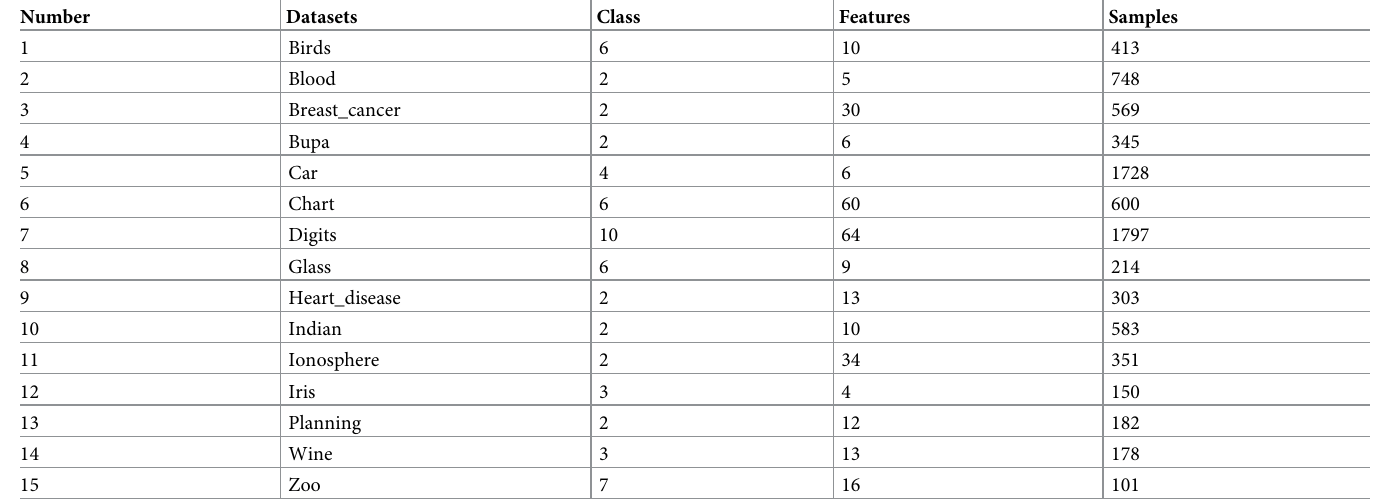
Table 2. Datasets used and their